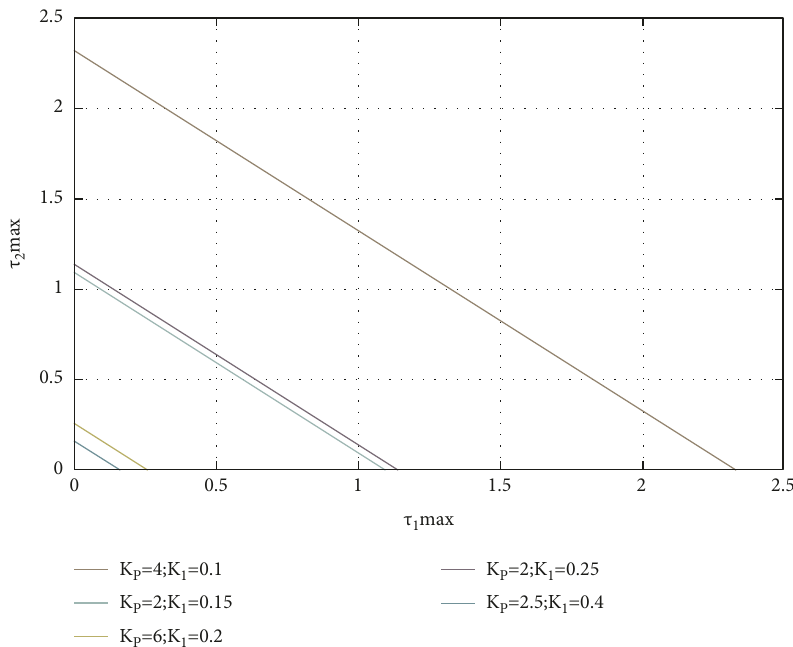
Figure 5: Heat exchanger thermal control resilience